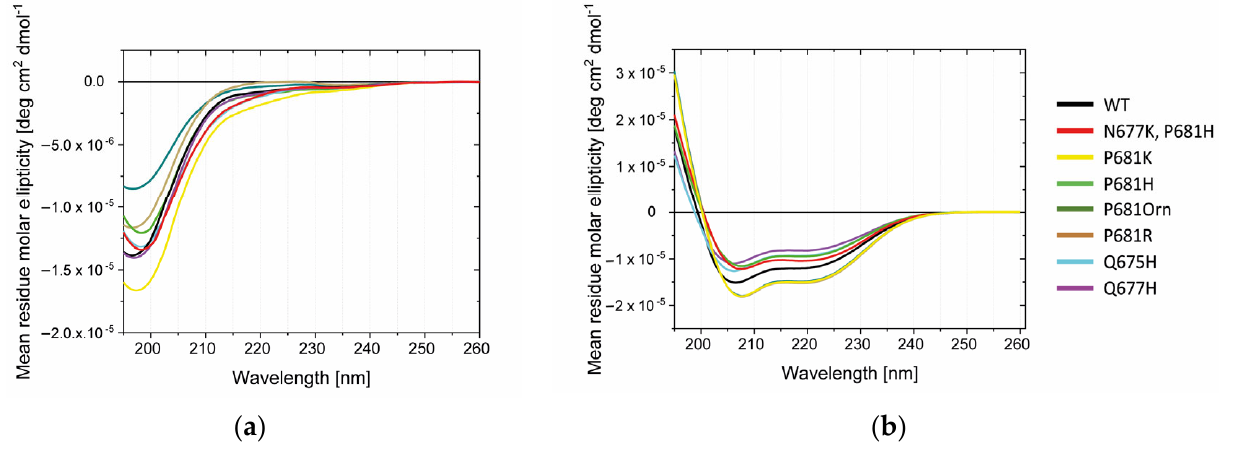
Figure 8. CD spectra of the SARS ‐ CoV ‐ 2 S ‐ derived peptides described in Table 1 in ( a ) water and ( b ) trifluoroethanol. Data are expressed as mean residue molar ellipticity (Raw data and calculations are reported in Supplementary Table S 1).